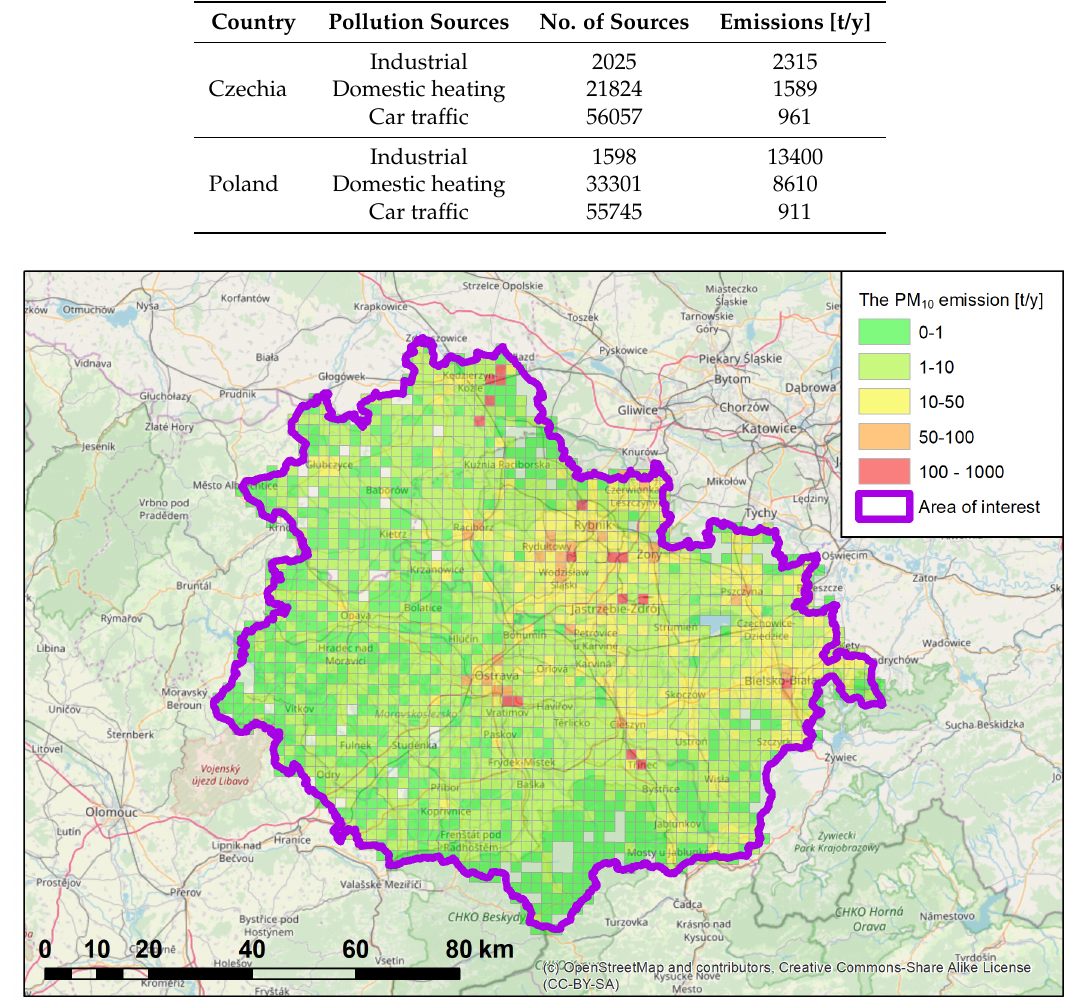
Figure 3. The PM 10 emission distribution in the study area, Basemap: